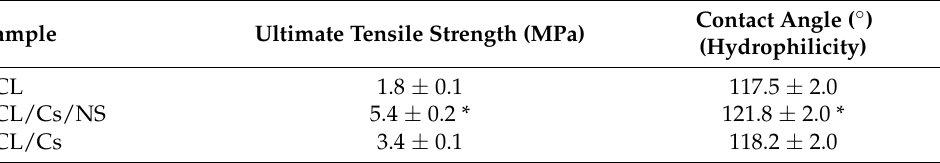
Table 3. Physical properties of the PCL/CS/NS nanofibers after cross-linking (*: p < 0.05).